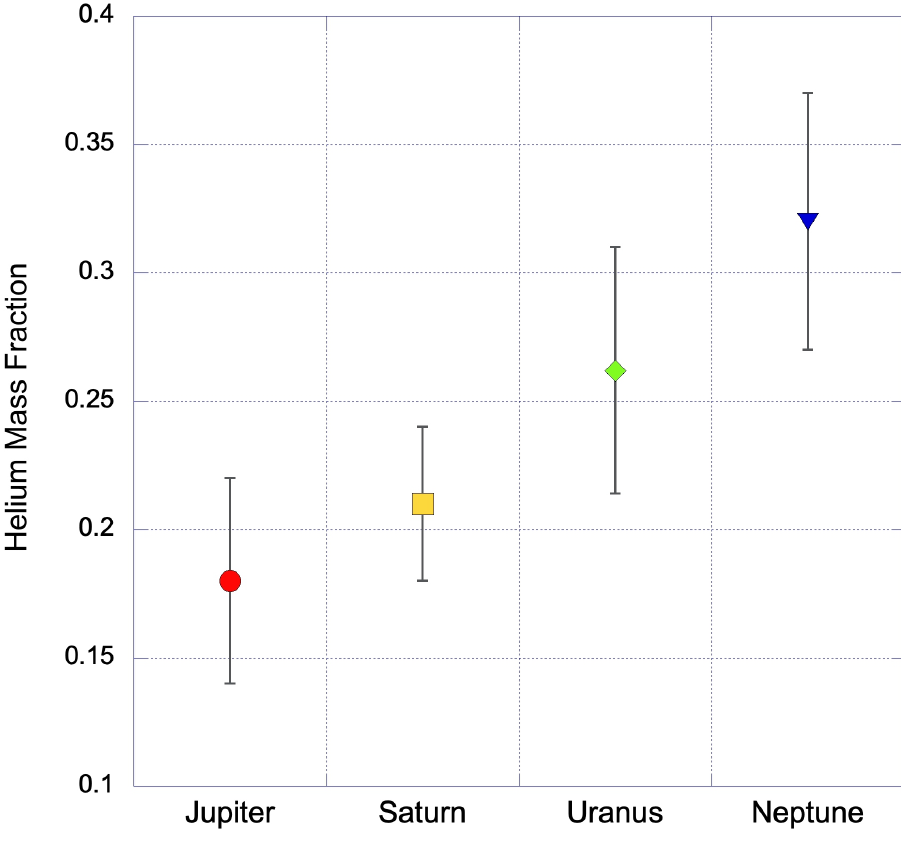
Figure 2. Helium abundances of Jupiter [9], Saturn [10], Uranus [11], and Neptune [12] derived from Voyager 1 and 2 IRIS